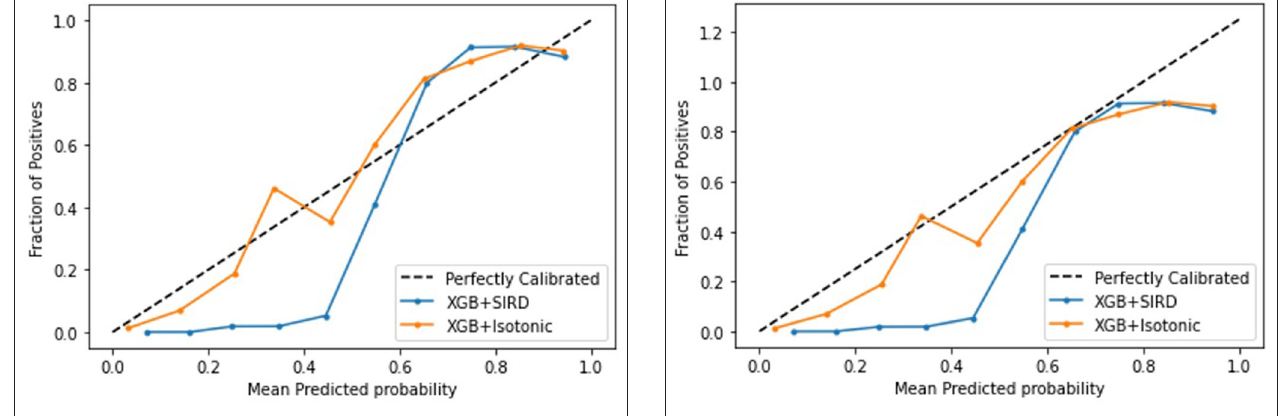
FIGURE 9 | XG Boost classifier calibration graph for class